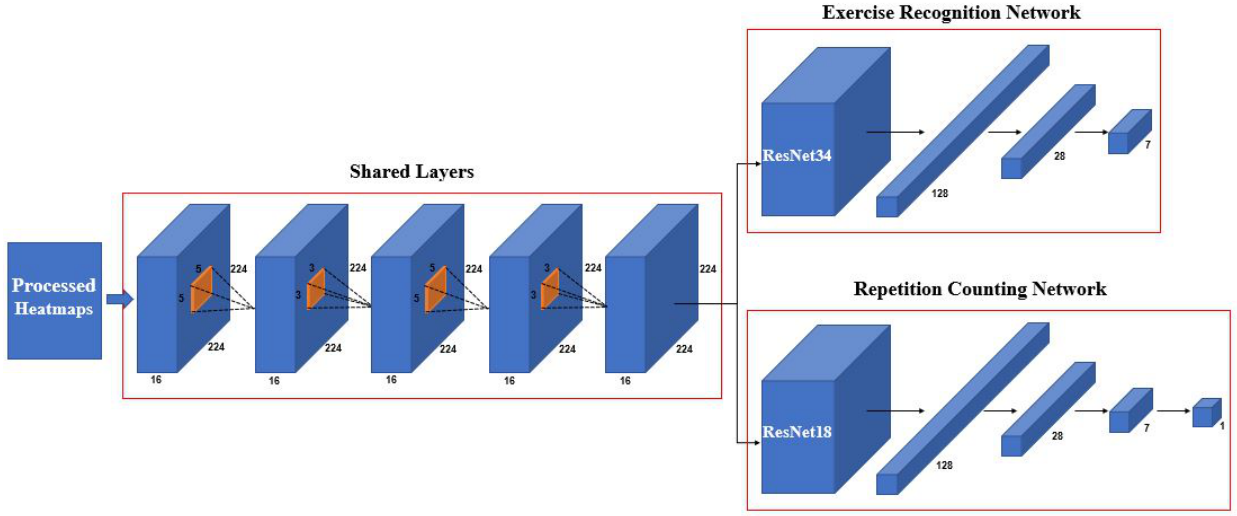
Figure 4. Illustration of the proposed multitask model. It consists of shared layers, an exercise recognition branch and a repetition counting